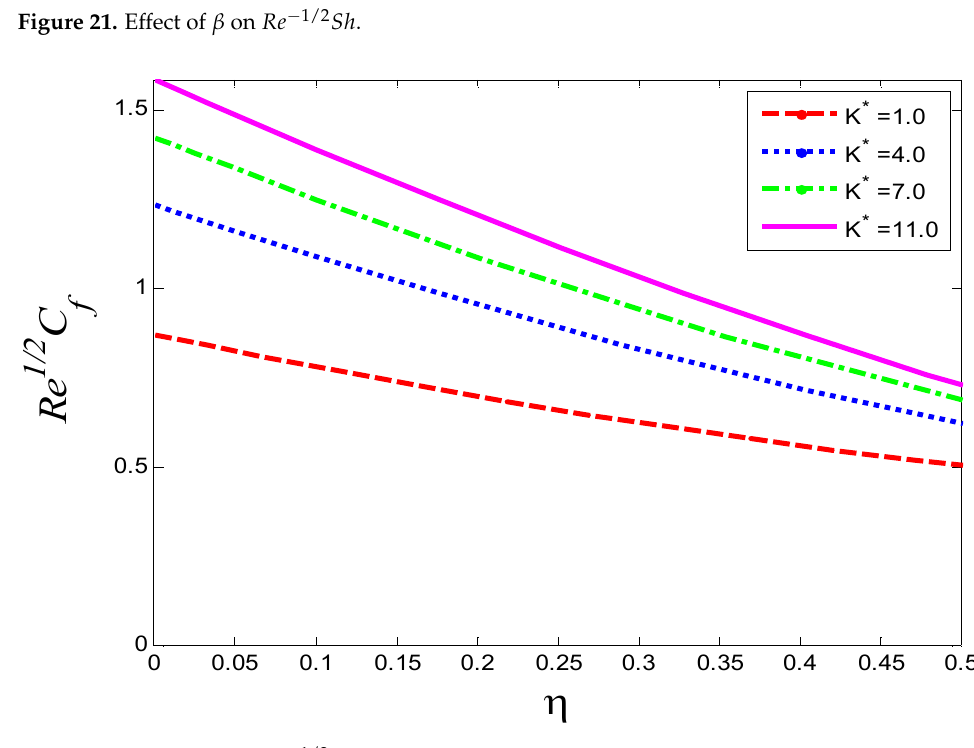
Figure 22. Effect of K ∗ on Re 1/2 C f